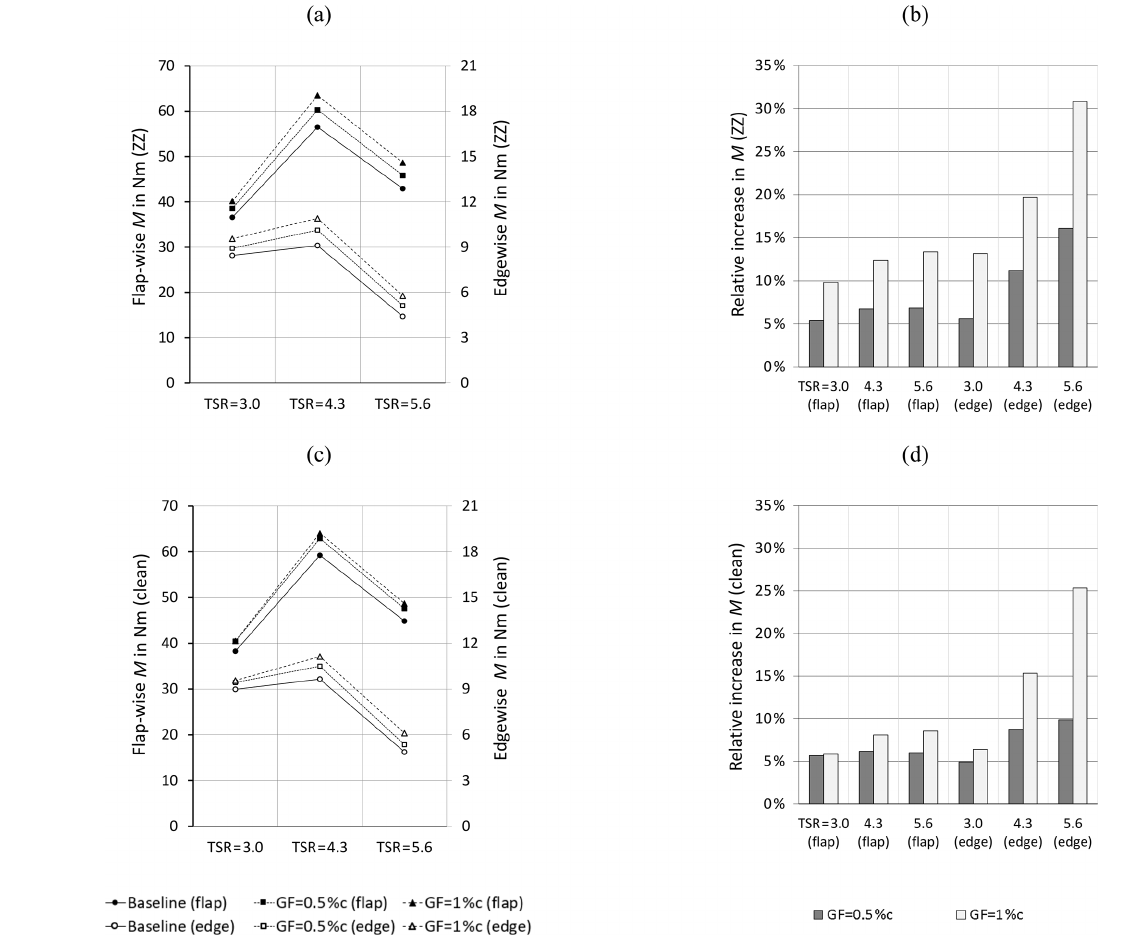
Figure 14. Flapwise (flap) and edgewise (edge) root bending moments. (a) Tripped case. (b) Relative increase to tripped baseline. (c) Clean case. (d) Relative increase to clean